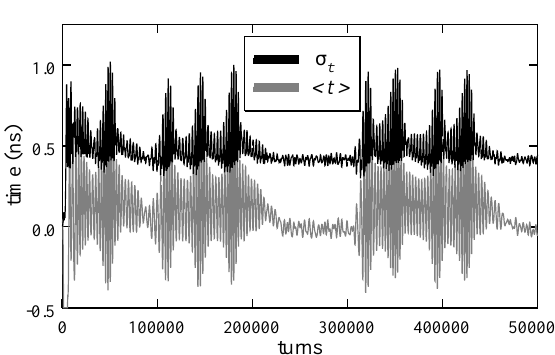
FIG. 14. Simulation of Robinson instability for active Landau- cavity operation with the LF20 lattice, for a ring current of 300 mA, b 2 (cid:1) 160 , and j (cid:1) 1.03